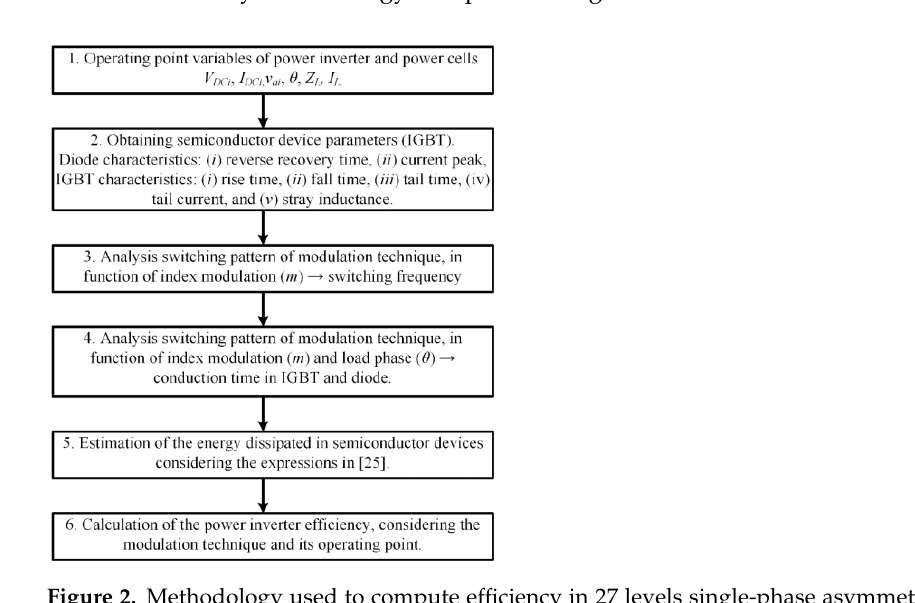
Figure 1. ( a ) Topology single-phase Cascaded H-Bridge for asymmetric inverters with 27 levels with regeneration, ( b ) individual output voltage for m =1.0, ( c ) output voltage for m = 1.0.